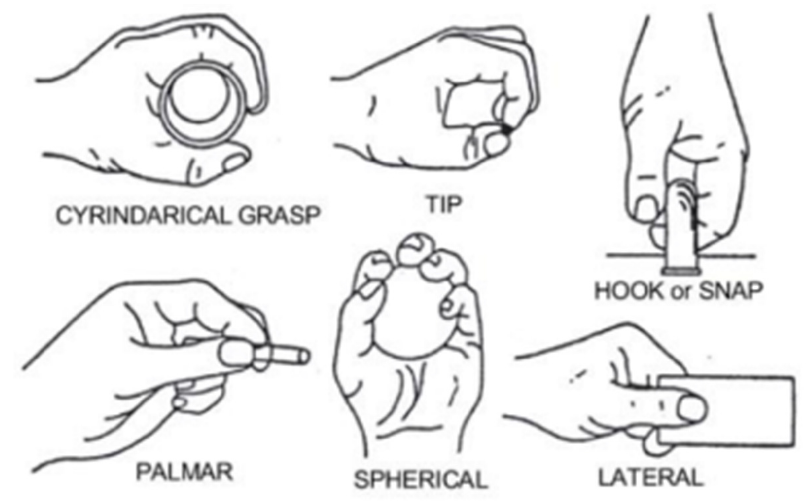
Figure 3. The grasping movements [27].